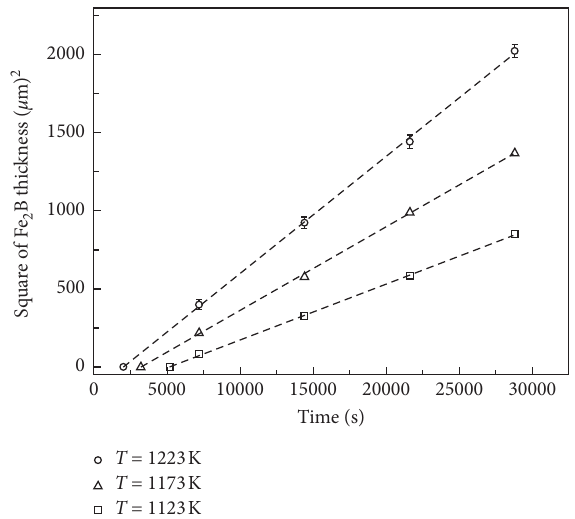
Figure 5: Growthevolutionoftheboridelayerthicknessat thesurface of AISI W2 steel, Fe 2 B phase as a function of the exposure